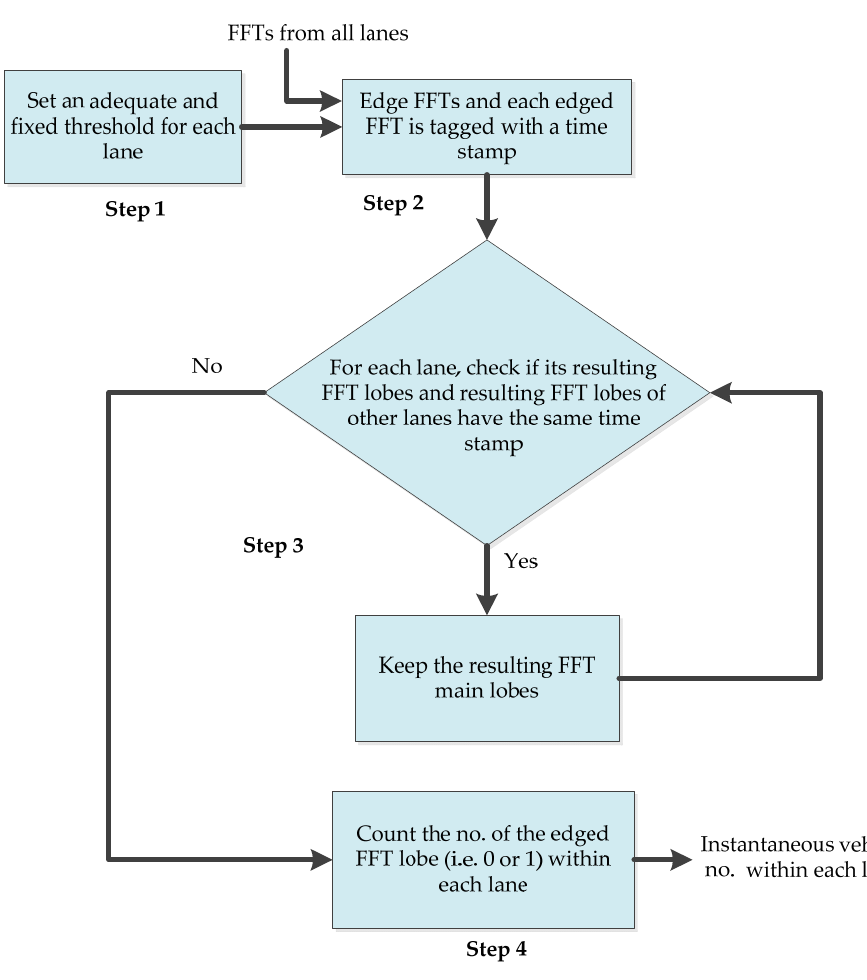
Figure 8. Functional procedure of the proposed alternative.